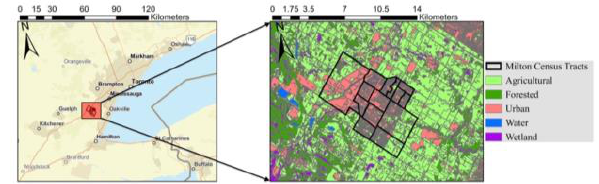
Figure 1 . The distribution of land covers surrounding Urban Milton, its designated census tracts, and its location within the GTA in the 2015 land cover